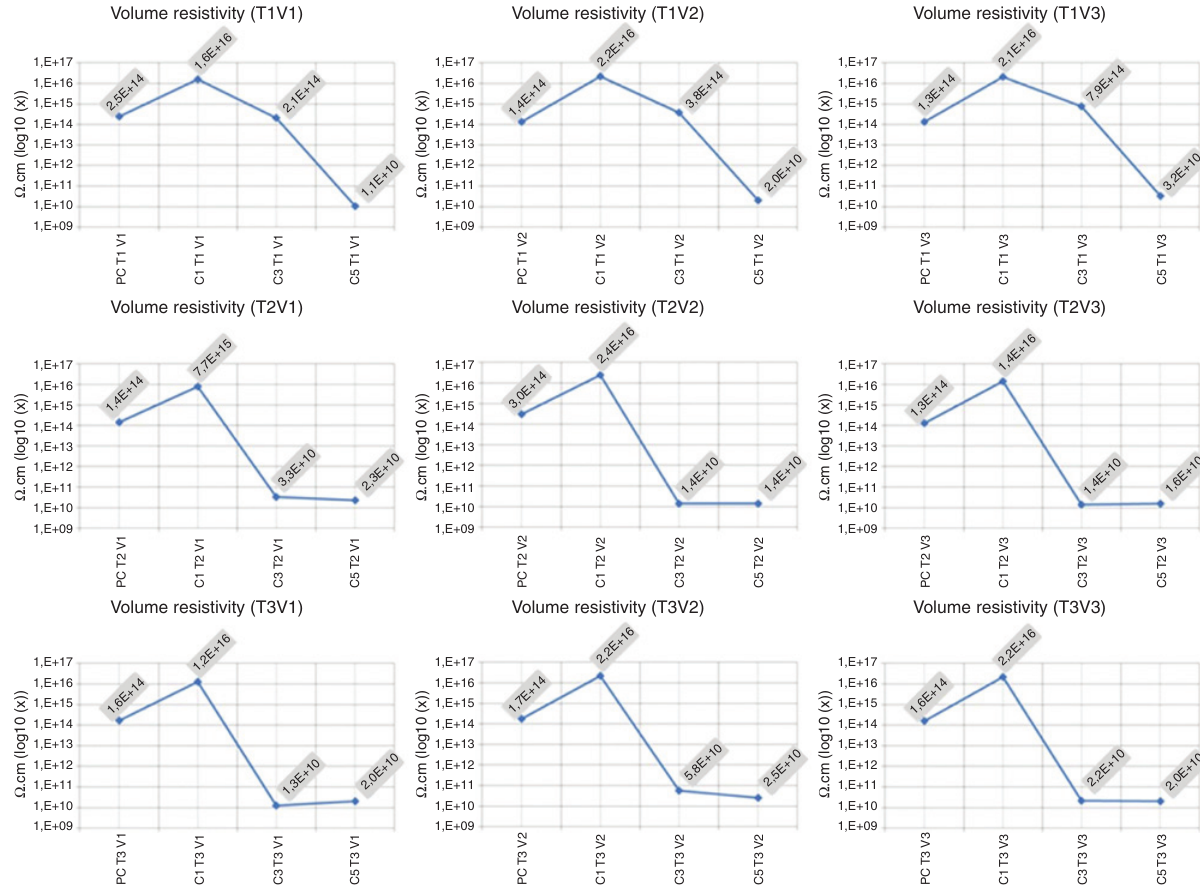
Figure 8 Resistivity values of nanocomposites according to their injection temperature, injection velocity and nanotube